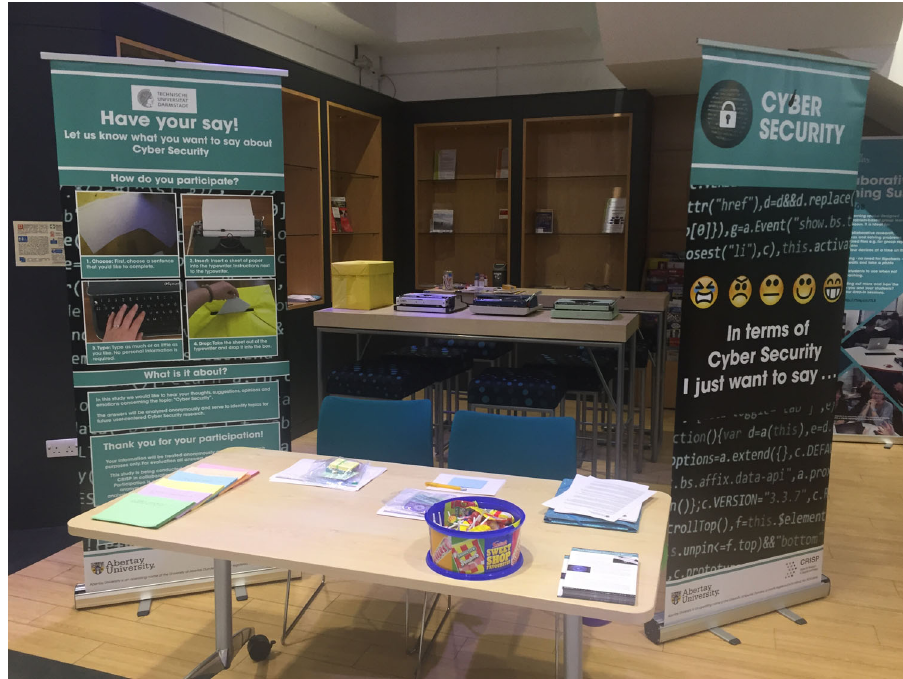
Fig. 8 The RETELL stall, with three manual typewriters on the back table, with the banners left and right to attract attention. Images used on the posters were from